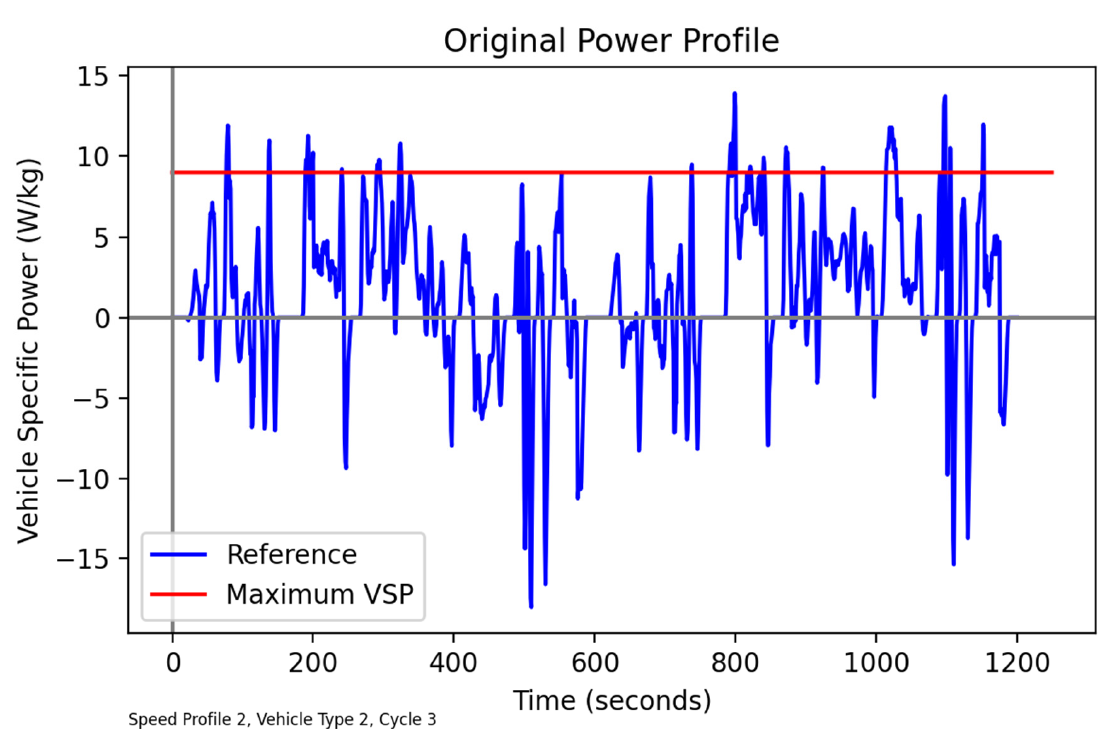
Figure 14. VSP profile obtained from applying WMTC Speed Profile 2 to the Lisbon case.